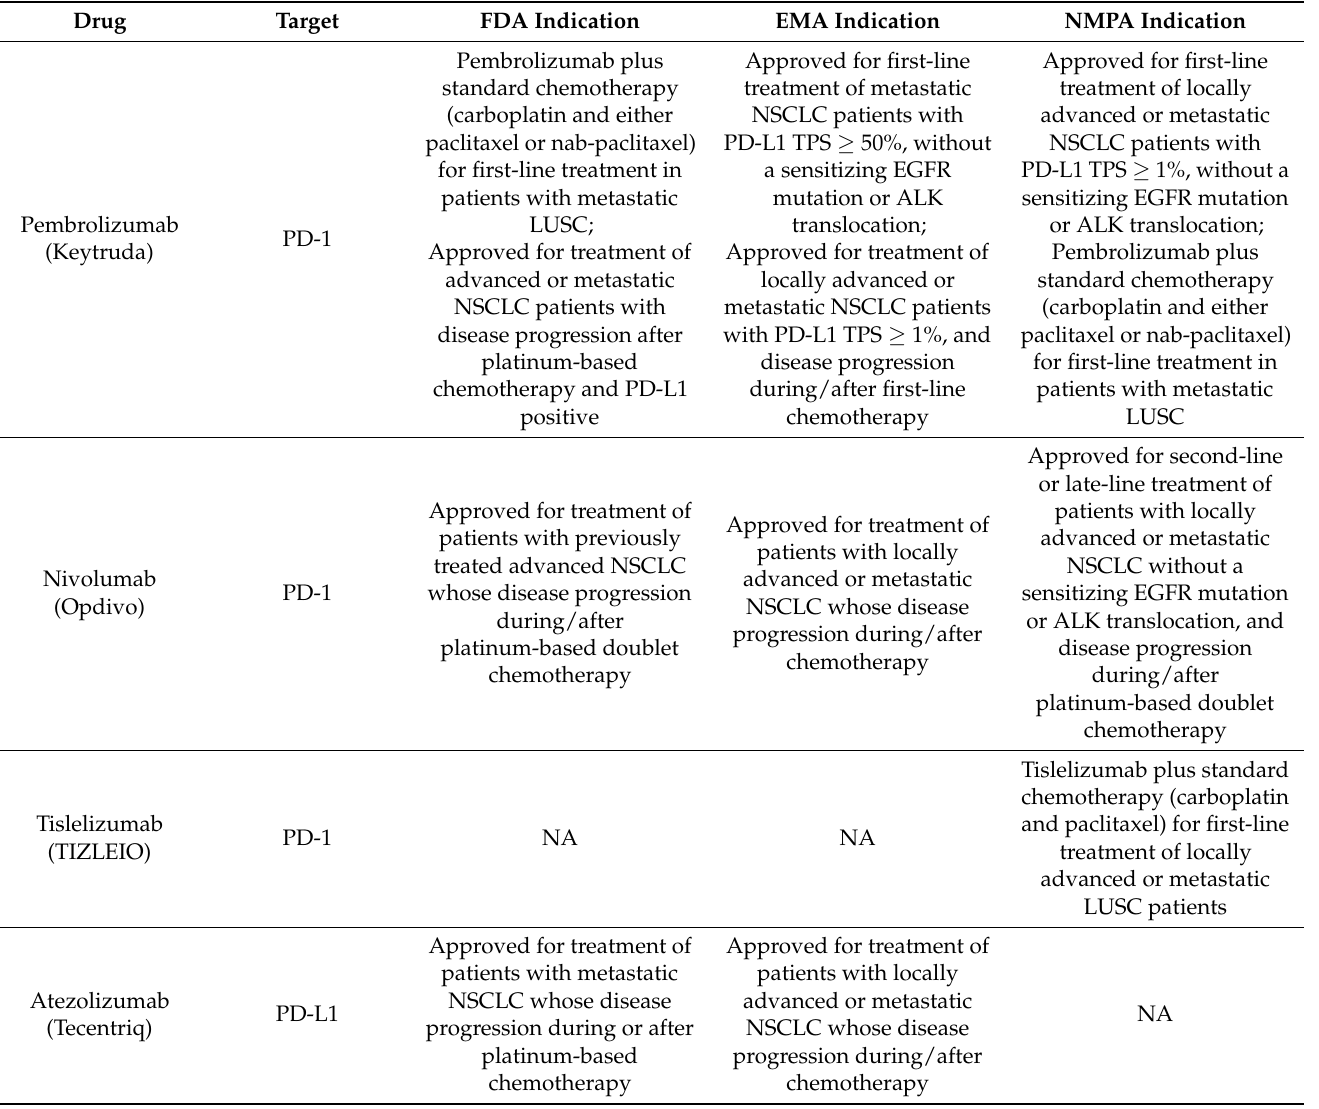
Table 1. Programmed death-1/programmed death ligand 1 (PD-1/PD-L1) inhibitors were used in clinical practice for lung squamous cell carcinoma (LUSC)